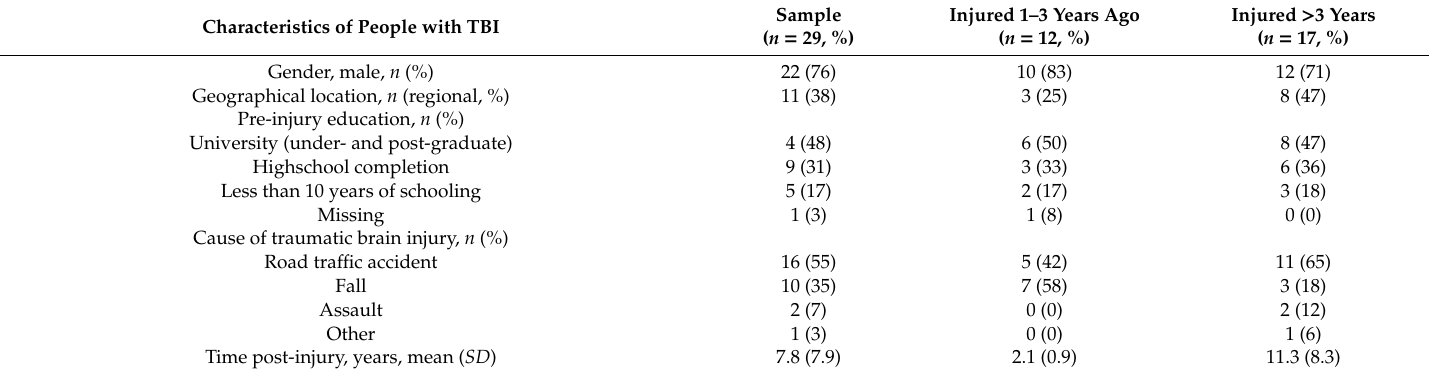
Table 2. Demographic characteristics of people with a traumatic brain injury